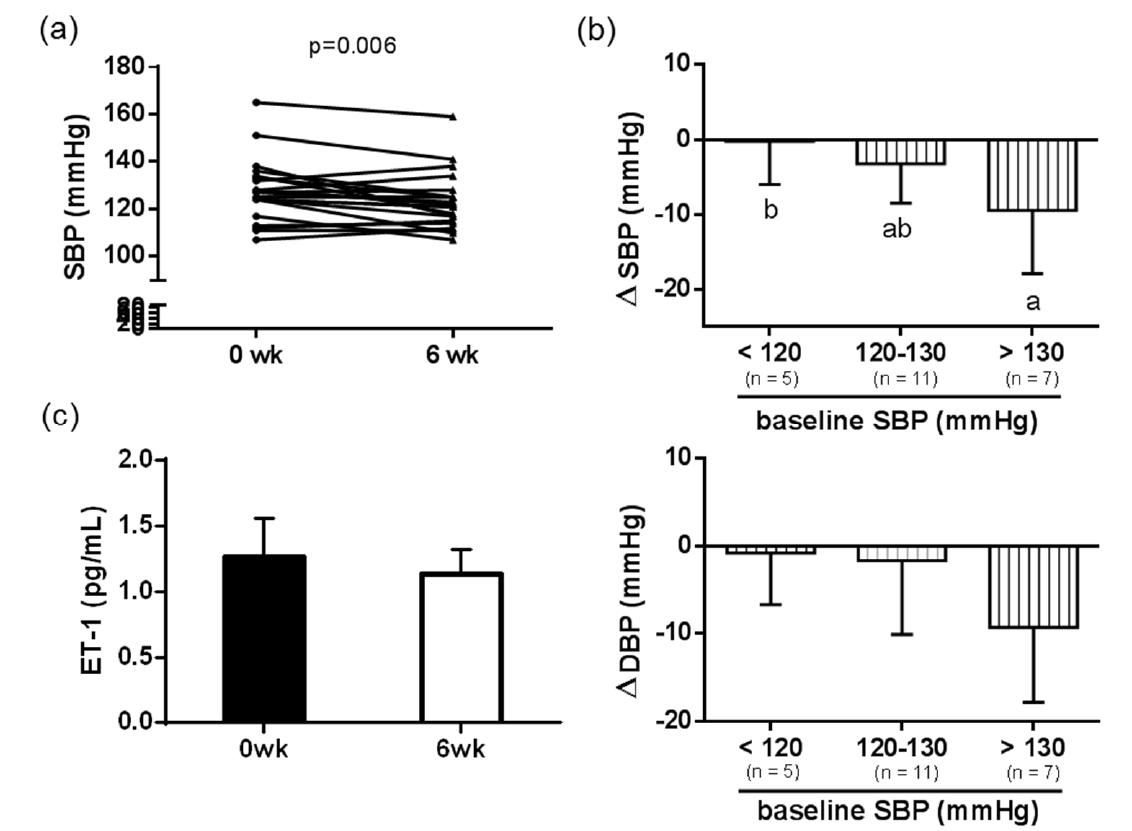
Figure 5. Baseline and end SBP ( a ) and ET-1 ( b ) levels, and changes in SBP and DBP ( c ) of participants subgrouping by baseline SBP after the 6-week dehulled adlay intervention. Values are presented as mean ± SD ( n = 23). ab Different superscript letters indicate a significant difference ( p < 0.05). SBP, systolic blood pressure; DBP, diastolic blood pressure; ET-1, endothelin-1.